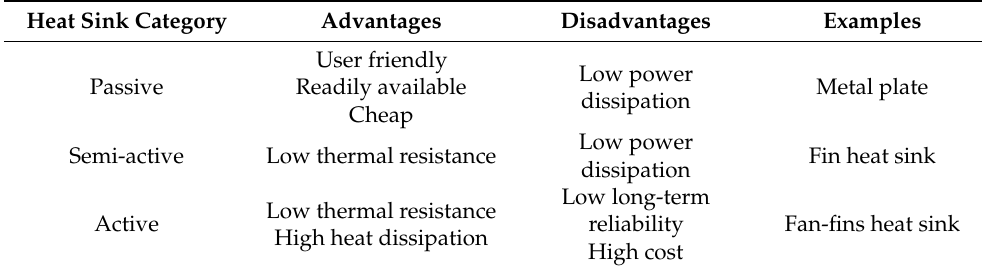
Table 3. Classification of heat sink groups